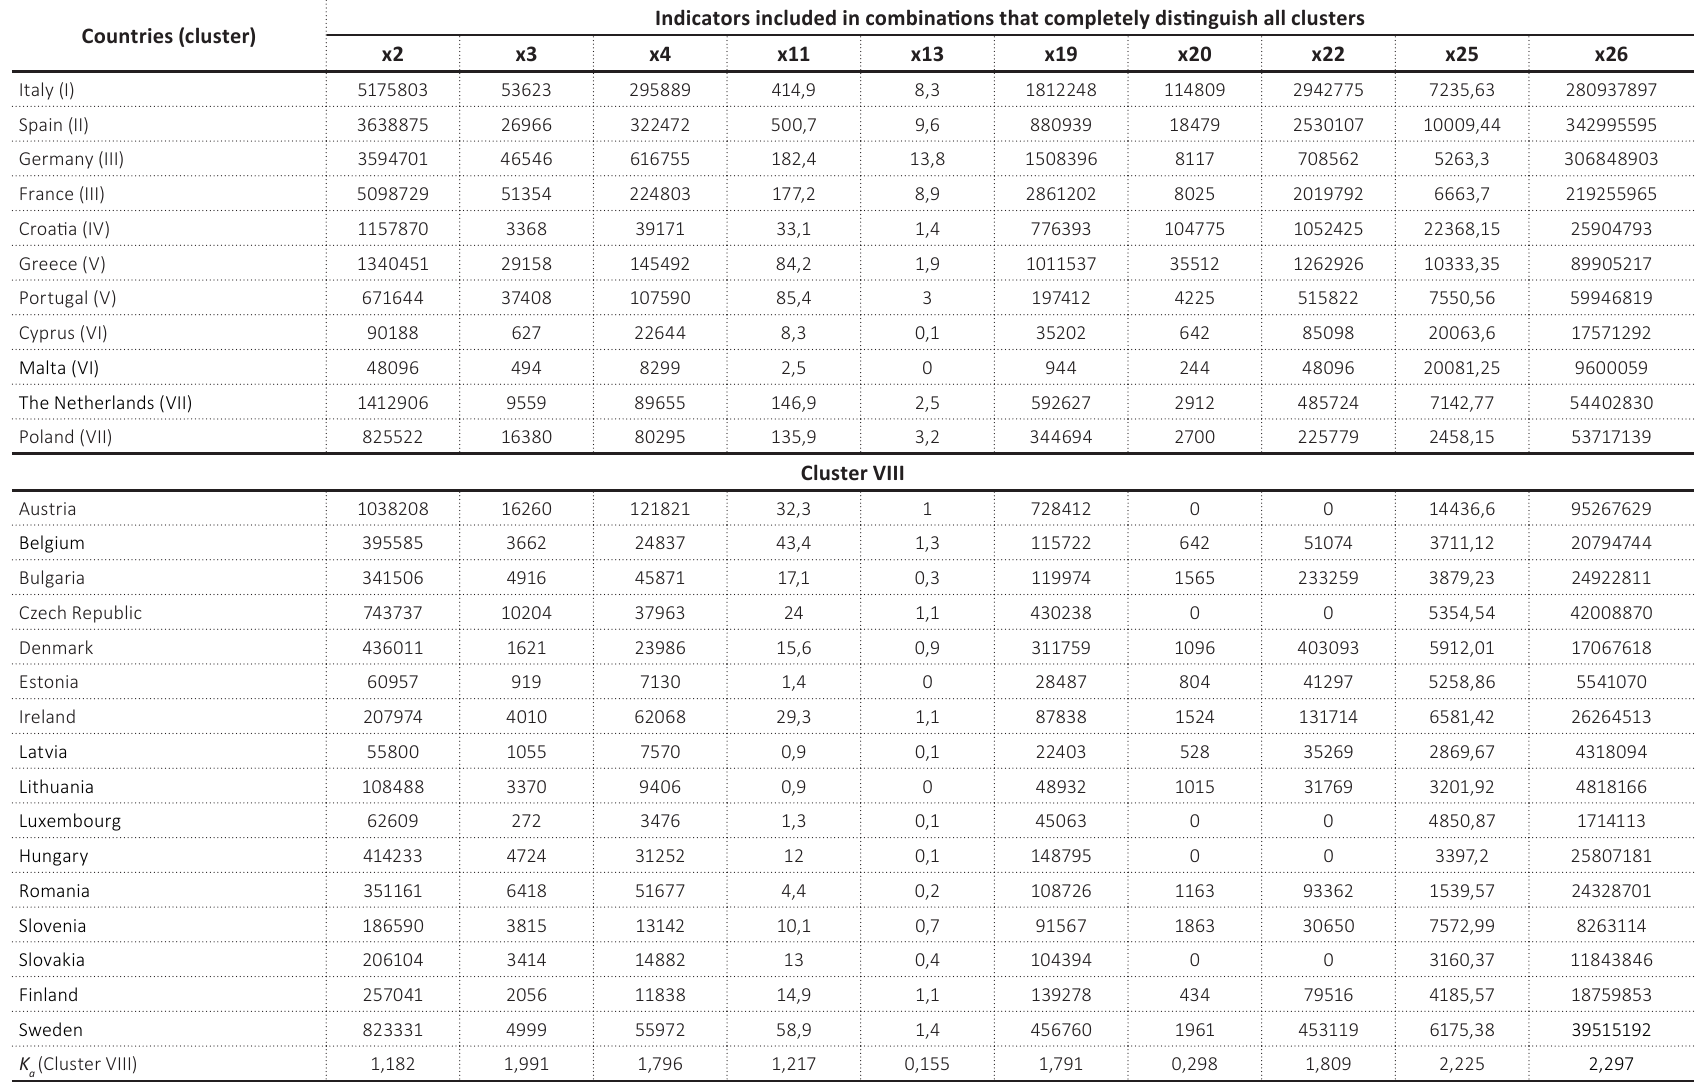
Table 4. Parametric analysis of the main asymmetry factors in the development of the EU tourism industry by the obtained clusters Indicators included in combinations that completely distinguish all clusters Countries (cluster) x2